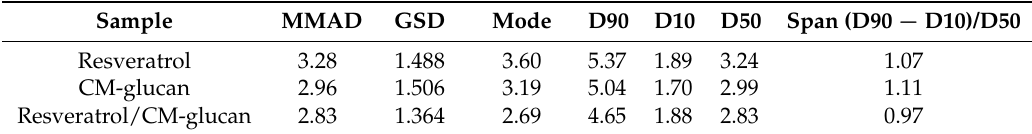
Table 1. Particle size distribution of liquid formulations of resveratrol and/or CM-glucan. MMAD = mass median aerodynamic diameter; GSD = geometric standard